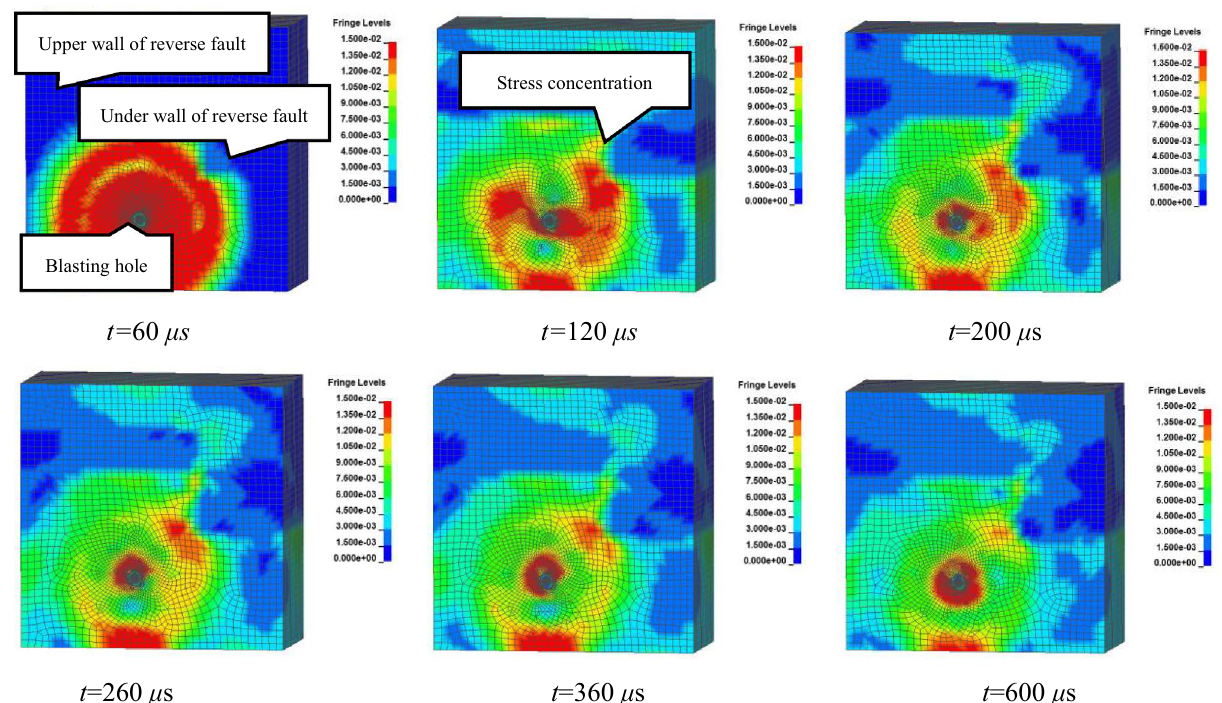
Figure 2. Part contours of 3-D effective stress at different times. (1) pressure gauge mounting hole; (2) pressure conduction device; (3) gas hole; (4) box wall; (5) hydraulic jackhole; (6) pressure transmitting steel plate; (7) bolt hole; (8) front cover plate; (9) blasting wireway lead hole; (10) back cover plate; (11) strain brick wireway lead